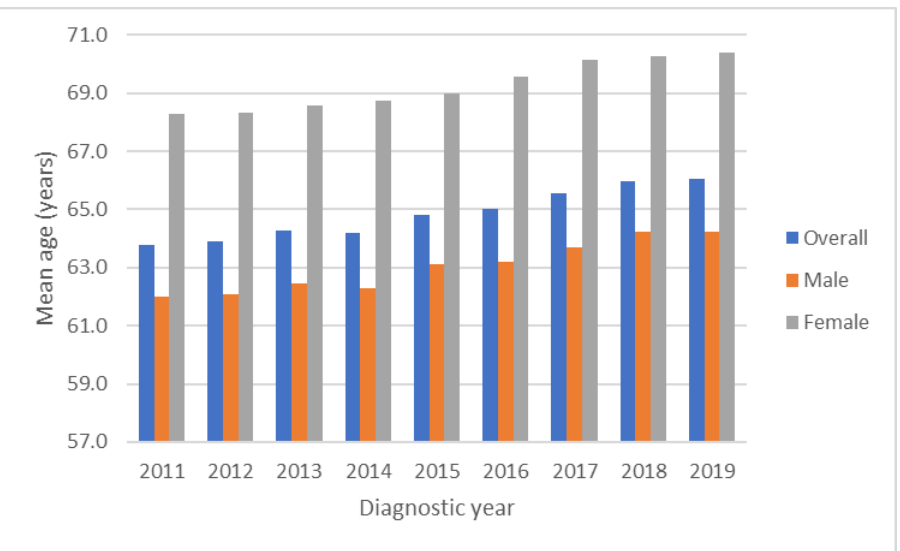
Figure 1. Secular trends of mean age from 2011 to 2019. The overall, male and female mean ages at diagnosis increasing annually over time (all p values for linear trend <0.01). Mean age of females were about 6 years older than males on average when diagnosis.